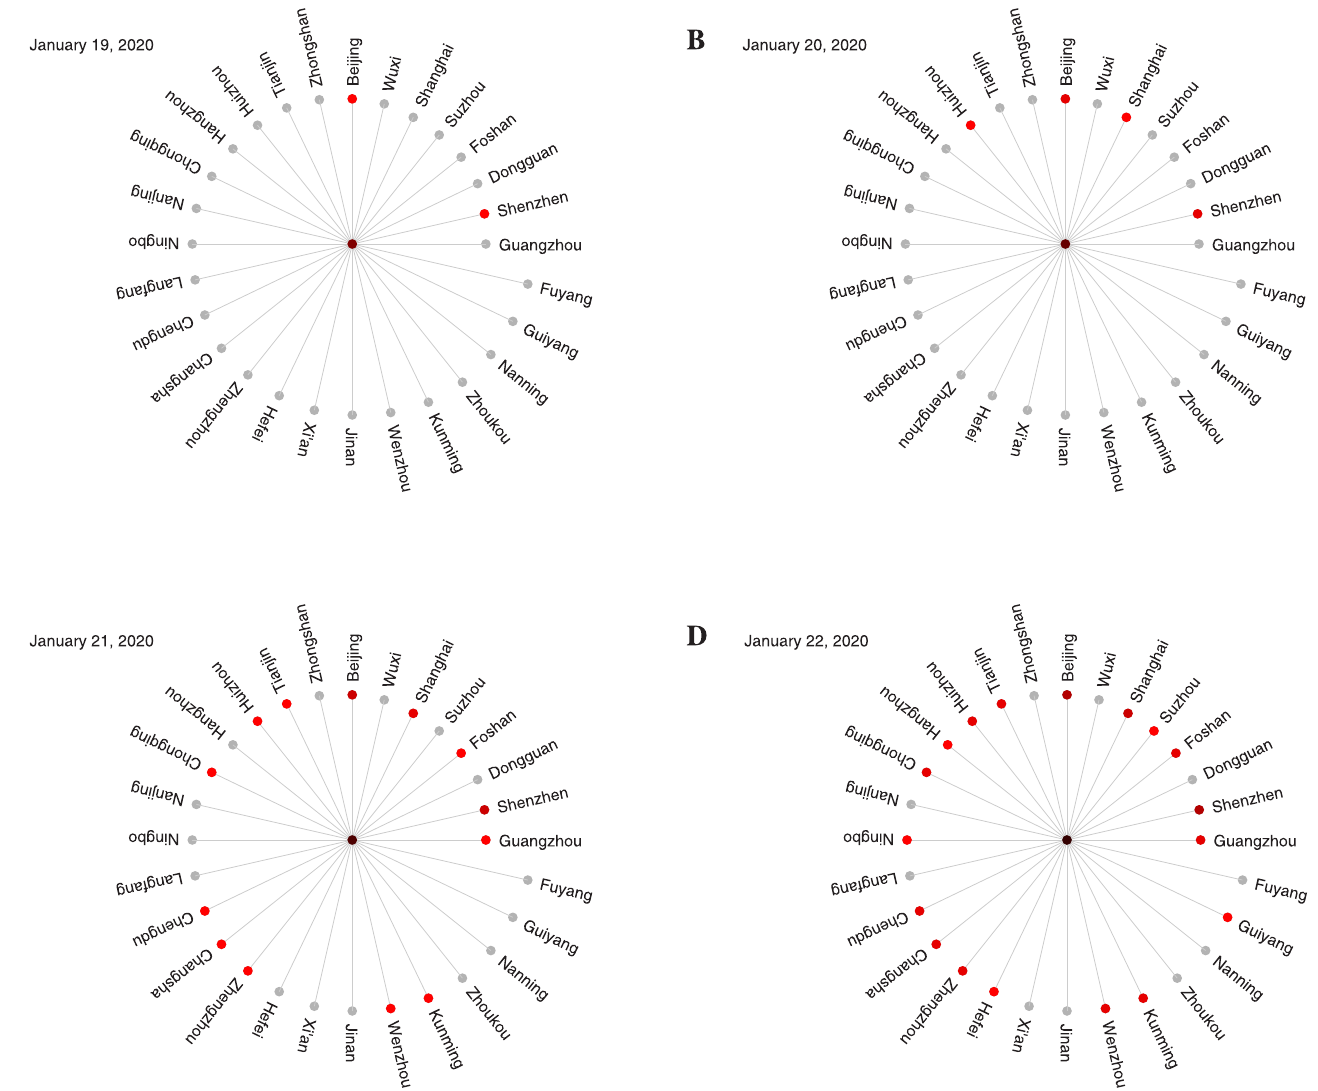
Fig 2. Epidemic invasion trees rooted in Wuhan. The sequence (from 19 to 22 January 2020) of panels depicts the early spread of the SARS-CoV-2 infection in 29 cities. The length of the polar path represents the diffusion distance from Wuhan to each city. The cities with confirmed infected individuals are marked in red, and the prevalence is reflected by the redness of the